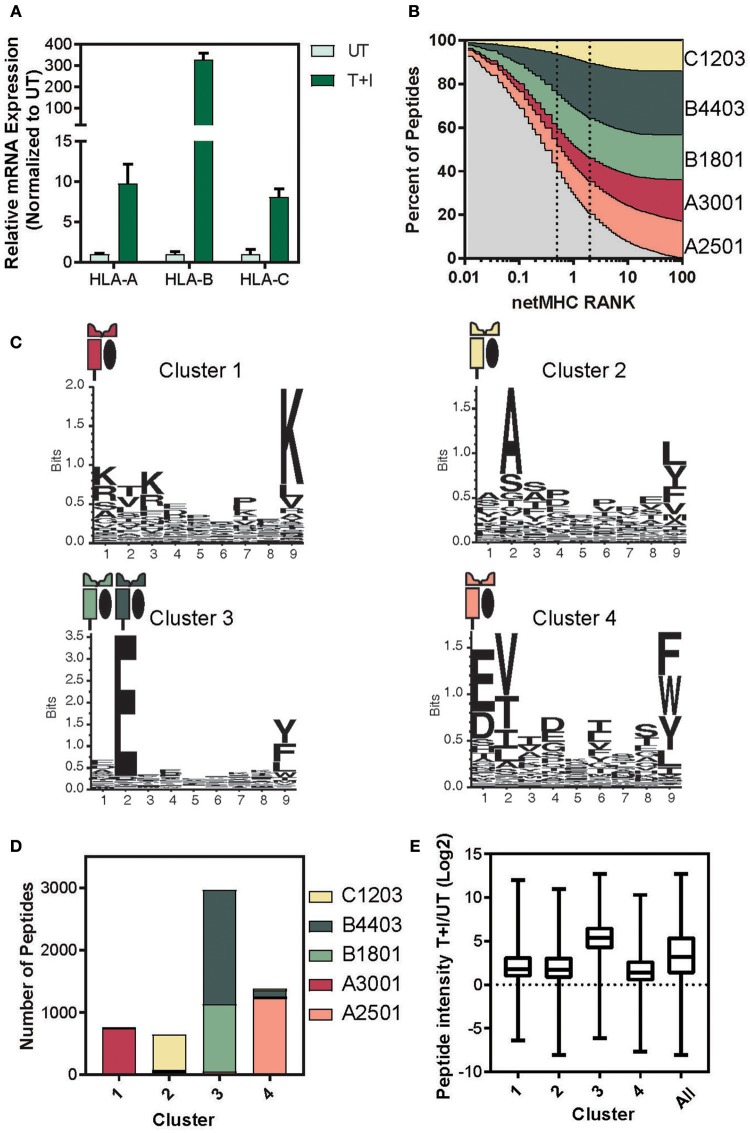
Determining the haplotype composition of A549 cells. (A) Relative levels of mRNA expression of HLA- A, B, and C with TNFα and IFNγ stimulation (T+I) or unstimulated (UT). GAPDH was used as an internal normalizing control and each gene was normalized to the UT sample. (B) NetMHC 4.0 was used to predict which of the identified presented peptides would bind to one of the HLA haplotypes found in A549 cells. The percentage of peptides identified which are predicted to bind to each haplotype is plotted against the threshold of binding rank (NetMHC RANK). The typical strong (rank = 0.5) and weak (rank = 2) binding threshold are indicated on the graph. (C) Gibbs clustering was performed on the identified peptides with four clusters. The motif of the peptides in each of the four clusters is displayed. (D) The number of peptides in each cluster predicted to bind to one of the A549 haplotypes. (E) The log2 transformed ratio of presented peptide intensity between cells stimulated with TNFα + IFNγ (T+I) and unstimulated (UT) for the peptides in each cluster (line at median, box for the second and third quartile, lines from min to max).